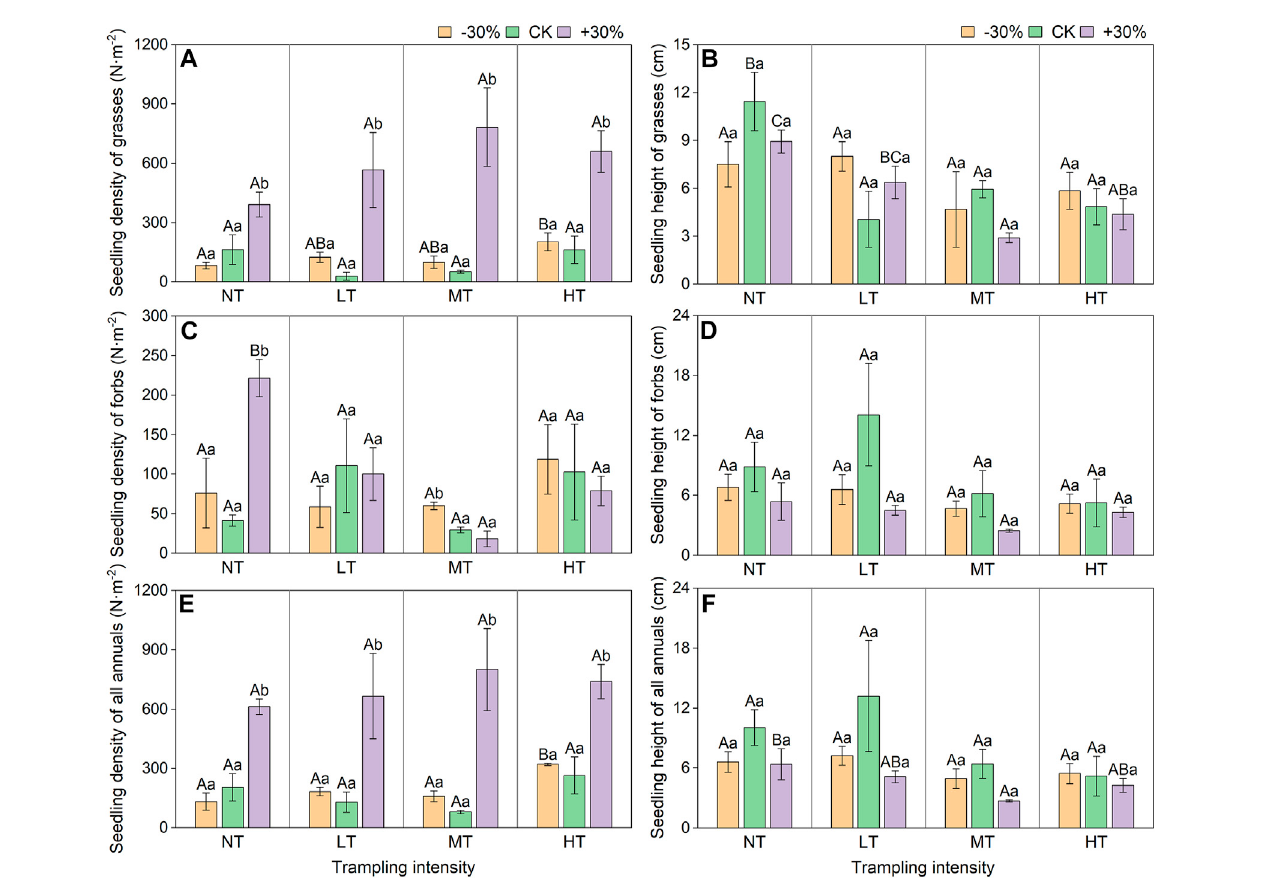
FIGURE 3 Effects ofprecipitation changes on seedling density and height underdifferenttrampling intensities. (A,B) :seedling density andheight ofgrasses; (C, D) : seedlingdensity andheightofforbs; (E,F) :seedlingdensity andheightofall annuals.NT,notrampling;LT,lighttrampling; MT,moderatetrampling;HT,heavy trampling. − 30%, decreased precipitation by 30%; CK, ambient precipitation; +30%, increased precipitation by 30%. Different lower-case letters indicate signi fi cant difference among precipitation treatments under same trampling intensity at 0.05 level, the same capital letters indicate no signi fi cant difference among trampling treatments in same precipitation condition at 0.05